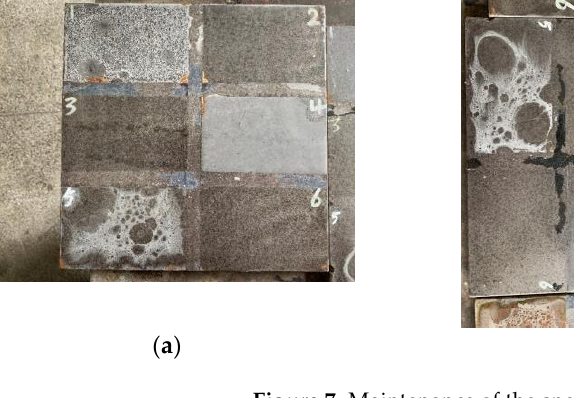
Figure 7. Maintenance of the specimen for the first week: ( a ) Room-temperature water bath diagram for the first week; ( b ) Room-temperature salt bath condition for the first week; ( c ) Room-temperature 60 °C water bath for the first week.